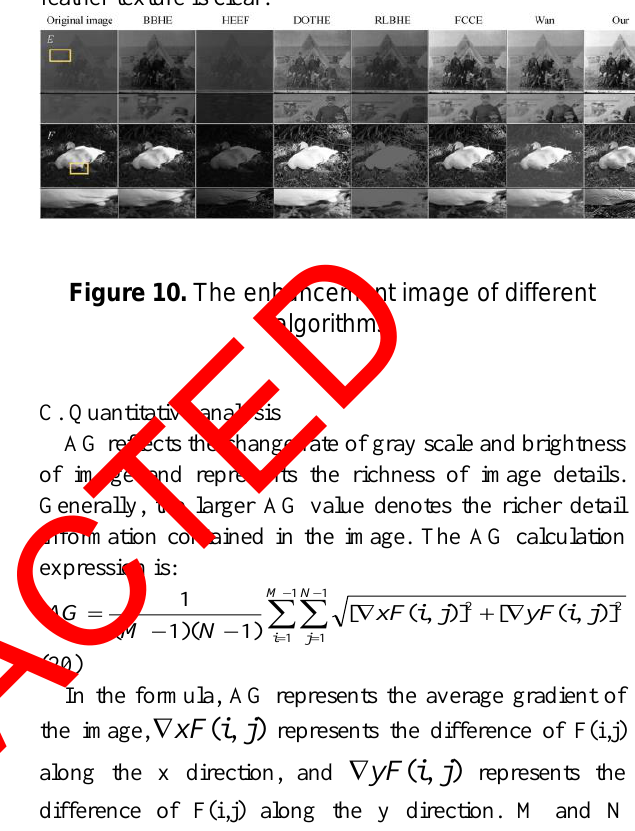
Figure 9. The enhancement effect of different algorithms